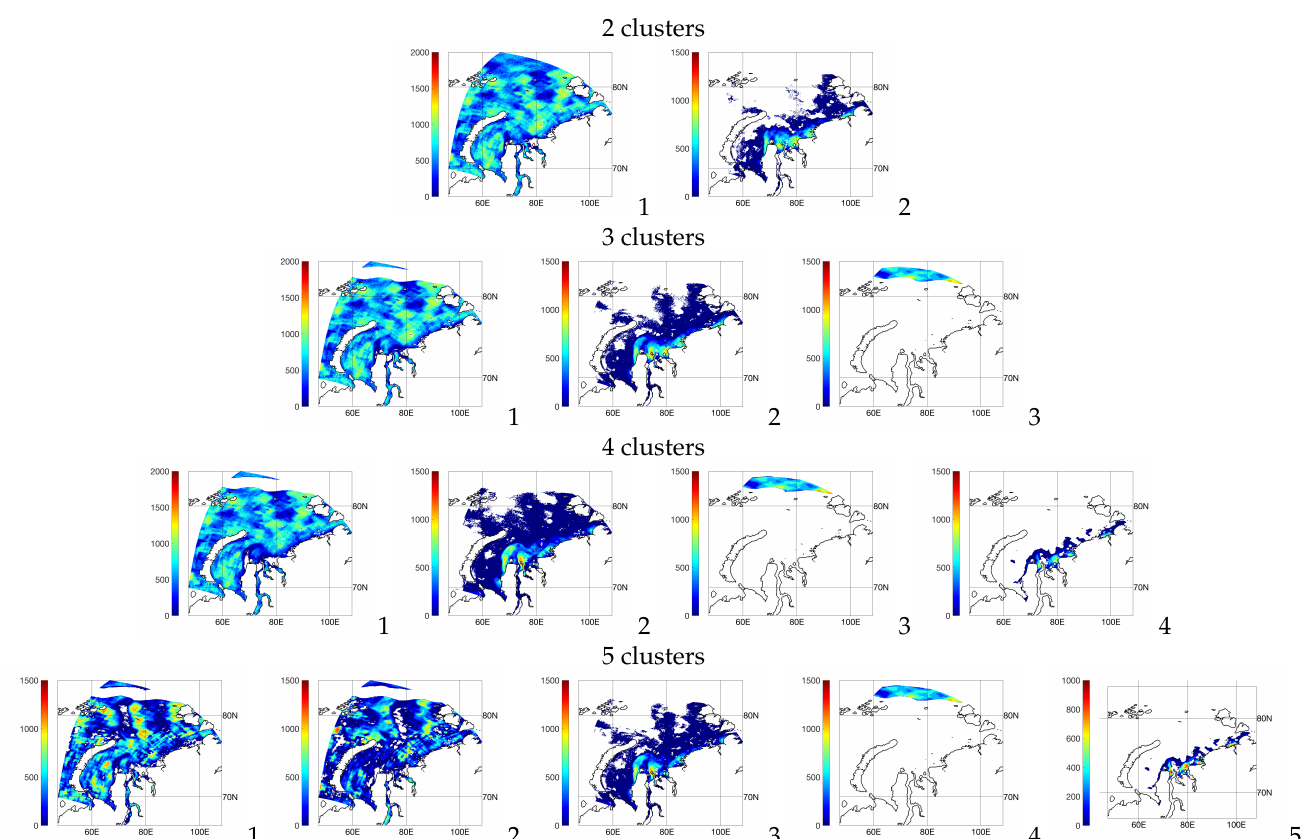
Figure 2. Geographical localization of clusters when the sample is split into 2, 3, 4, and 5 clusters. The cluster numbers in order of descending quantities of elements is to the right of the panels. Colors represent the horizontal distribution of the number of elements of each cluster corresponding to each model grid cell according to